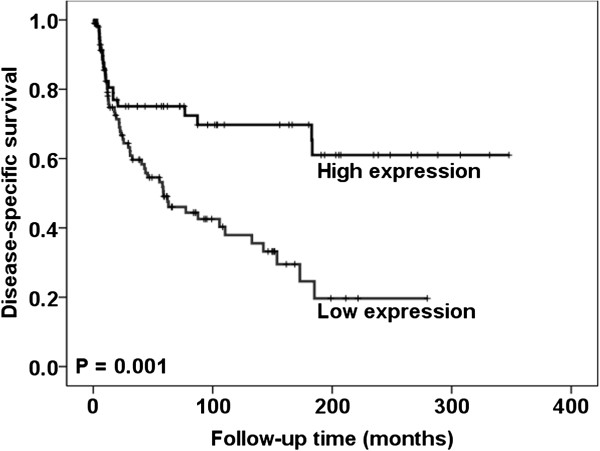
Survival curves using the Kaplan-Meier method. The Kaplan-Meier curve of disease-specific survival in relation to the HIF-1α showed that patients whose tumors expressed low levels of HIF-1α had a worse prognosis than those with high levels.